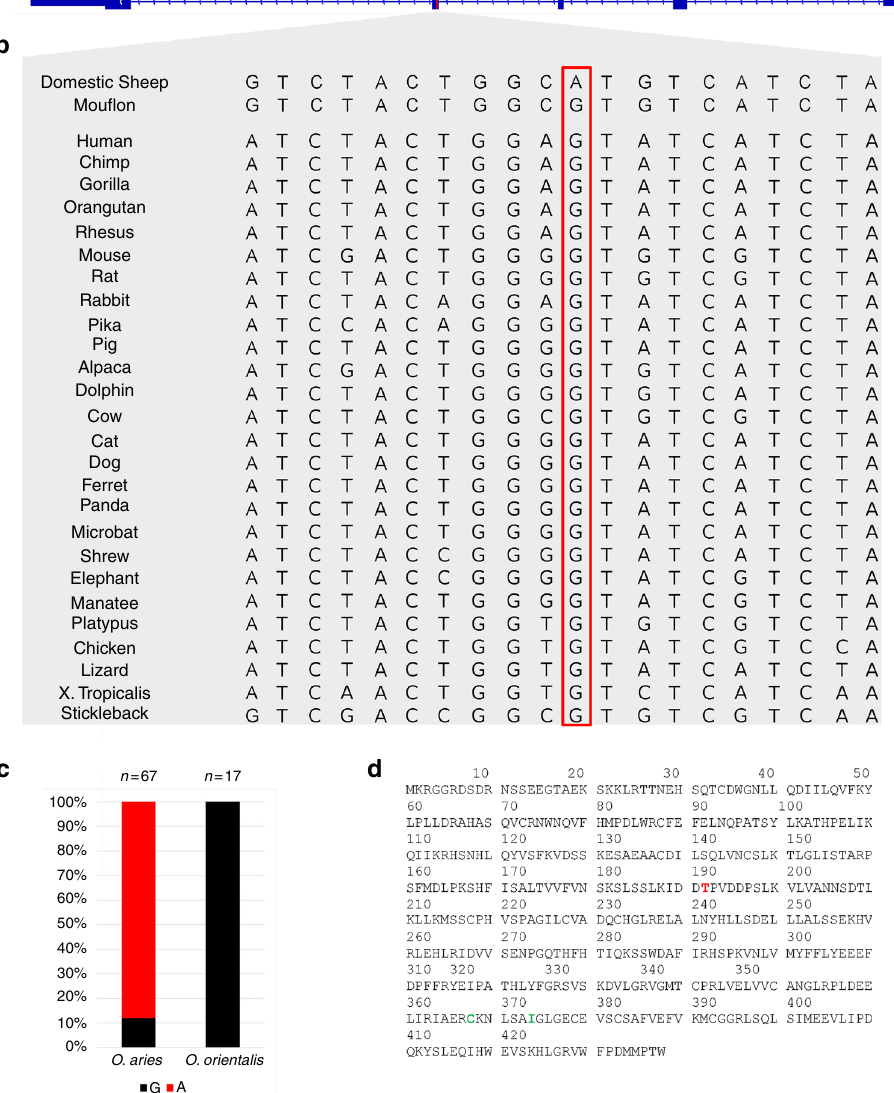
Fig. 5 Candidate causal missense mutation in FBXL3 . a FBXL3 gene representation in human hg19 coordinates chr13:77579389-77601337. b Multiple sequence alignment of SNP across representative vertebrates. c Allele frequency of the G (reference) or A (alternative) allele in domestic sheep ( O. aries ) ( n = 67) or mou fl on ( O. orientalis ) ( n = 17). d FBXL3 amino acid sequence with the substitution at residue 182 highlighted in red. Residue 358 (green) is associated with the mouse After hour (Afh) phenotype residue 364 with the overtime phenotype